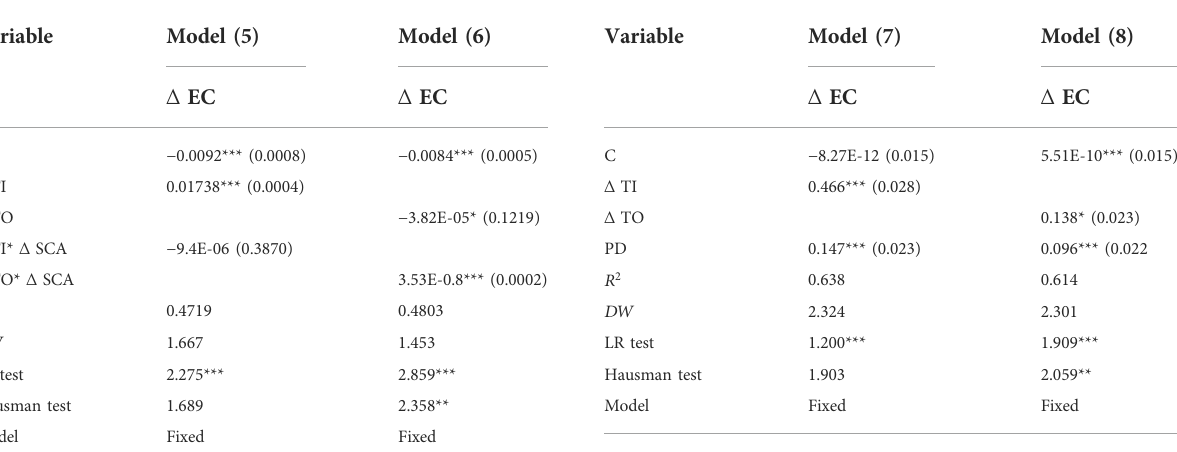
TABLE 8 Test results for the mediating role of product